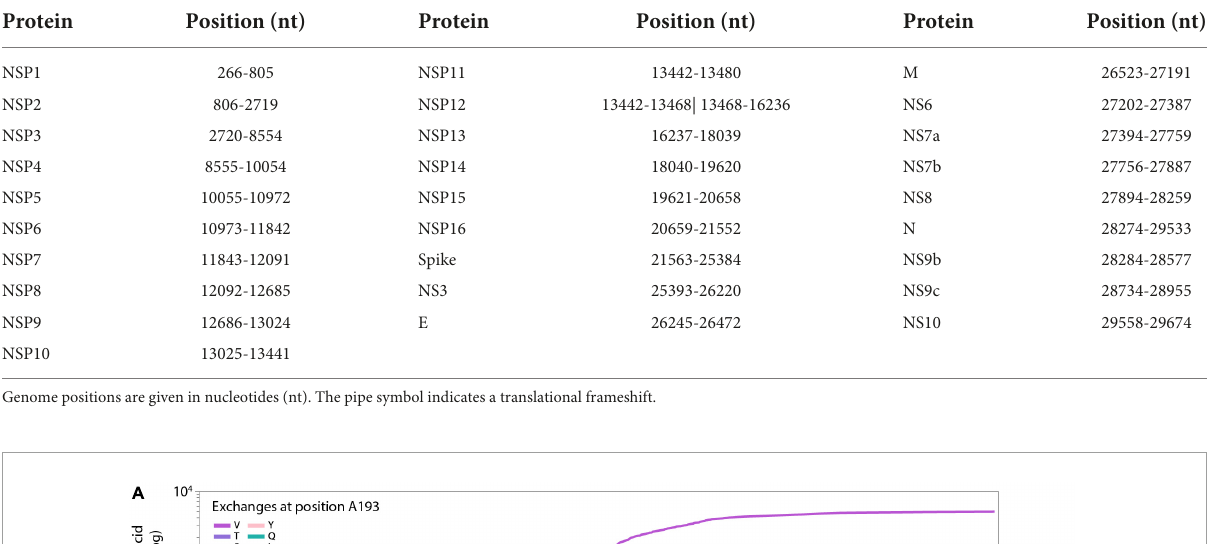
TABLE 1 Positions of the 28 proteins within the NCBI reference genome sequence NC_045512.2.